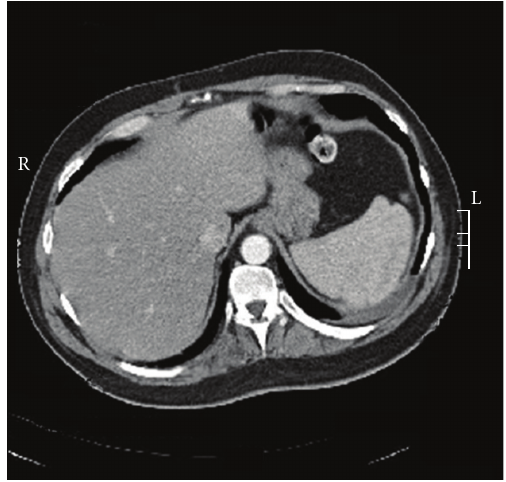
Figure 2: Post-op contrast CT abdomen showing normal abdomi- nal aorta at its origin.